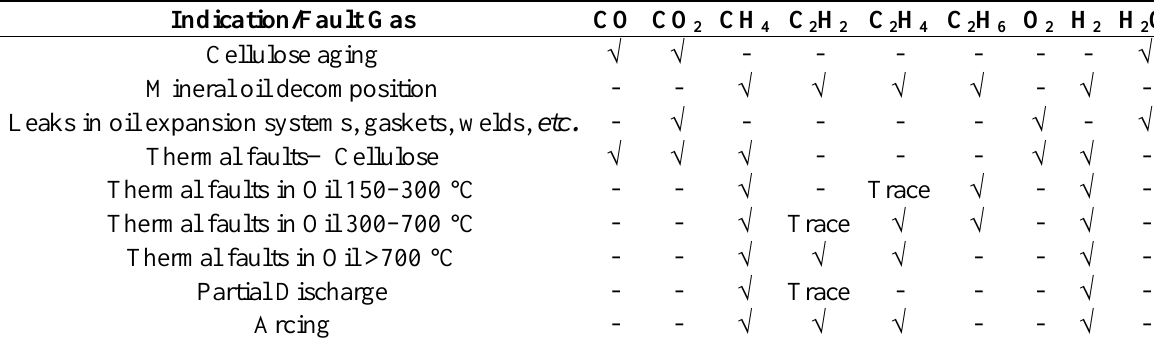
Table 8. Fault types indicated by a variety of